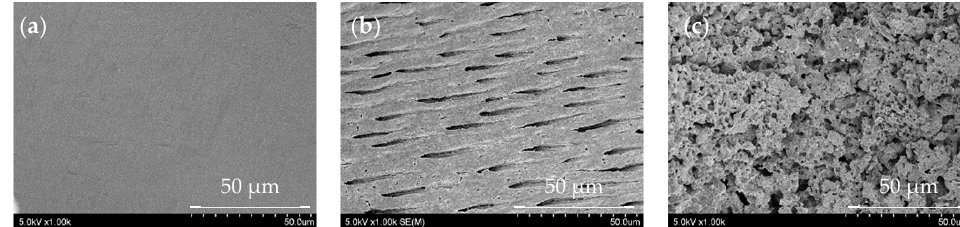
Figure 4. Classification of simulated root canal walls by morphology. ( a ) Flat surface, ( b ) dentinal Figure 4. Classi fi cation of simulated root canal walls by morphology. ( a ) Flat surface, ( b ) tubular surface, and ( c ) lava-like